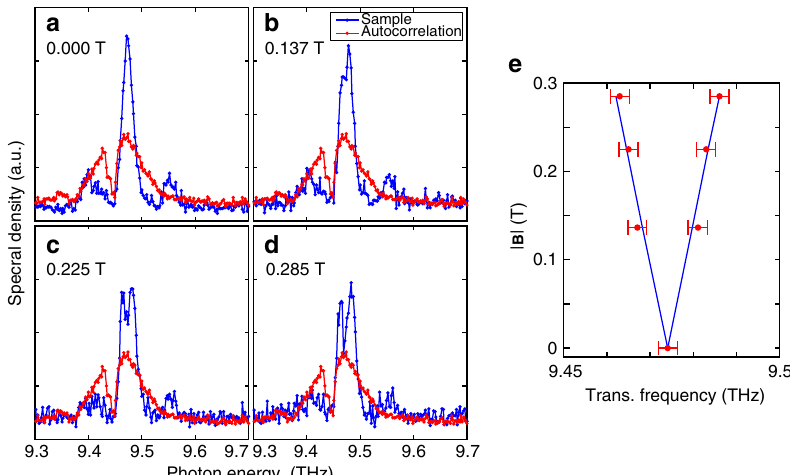
Figure 7 | Splitting of the 1 s to 2 p ± transition measured in absorption. ( a – d ) Spectra of the 1 s (A 1 ) to 2 p ± transition, measured using absorption (PTIS) for a variety of magnetic fields noted in the figure. The data have lower frequency resolution and lower statistical power from averaging than those of Fig. 6 to provide a better coverage of the magnetic field degree of freedom. ( e ) Extracted peak locations from ( a – d ) (red points) with error bars showing ± one datapoint, compared to the expected variation (blue trace), at the four different magnetic field amplitudes shown in a – d